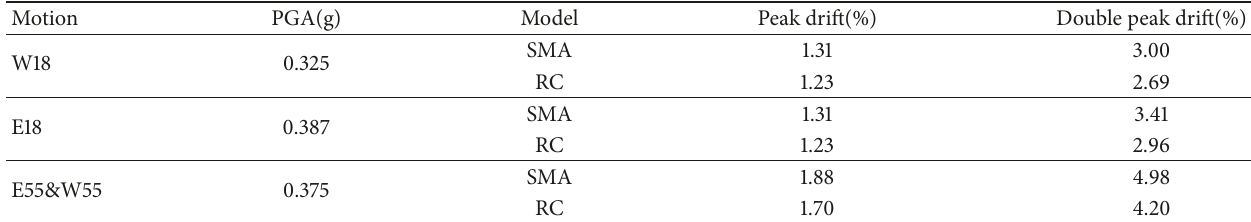
Table 1: Results in the transverse direction under uniform excitation.